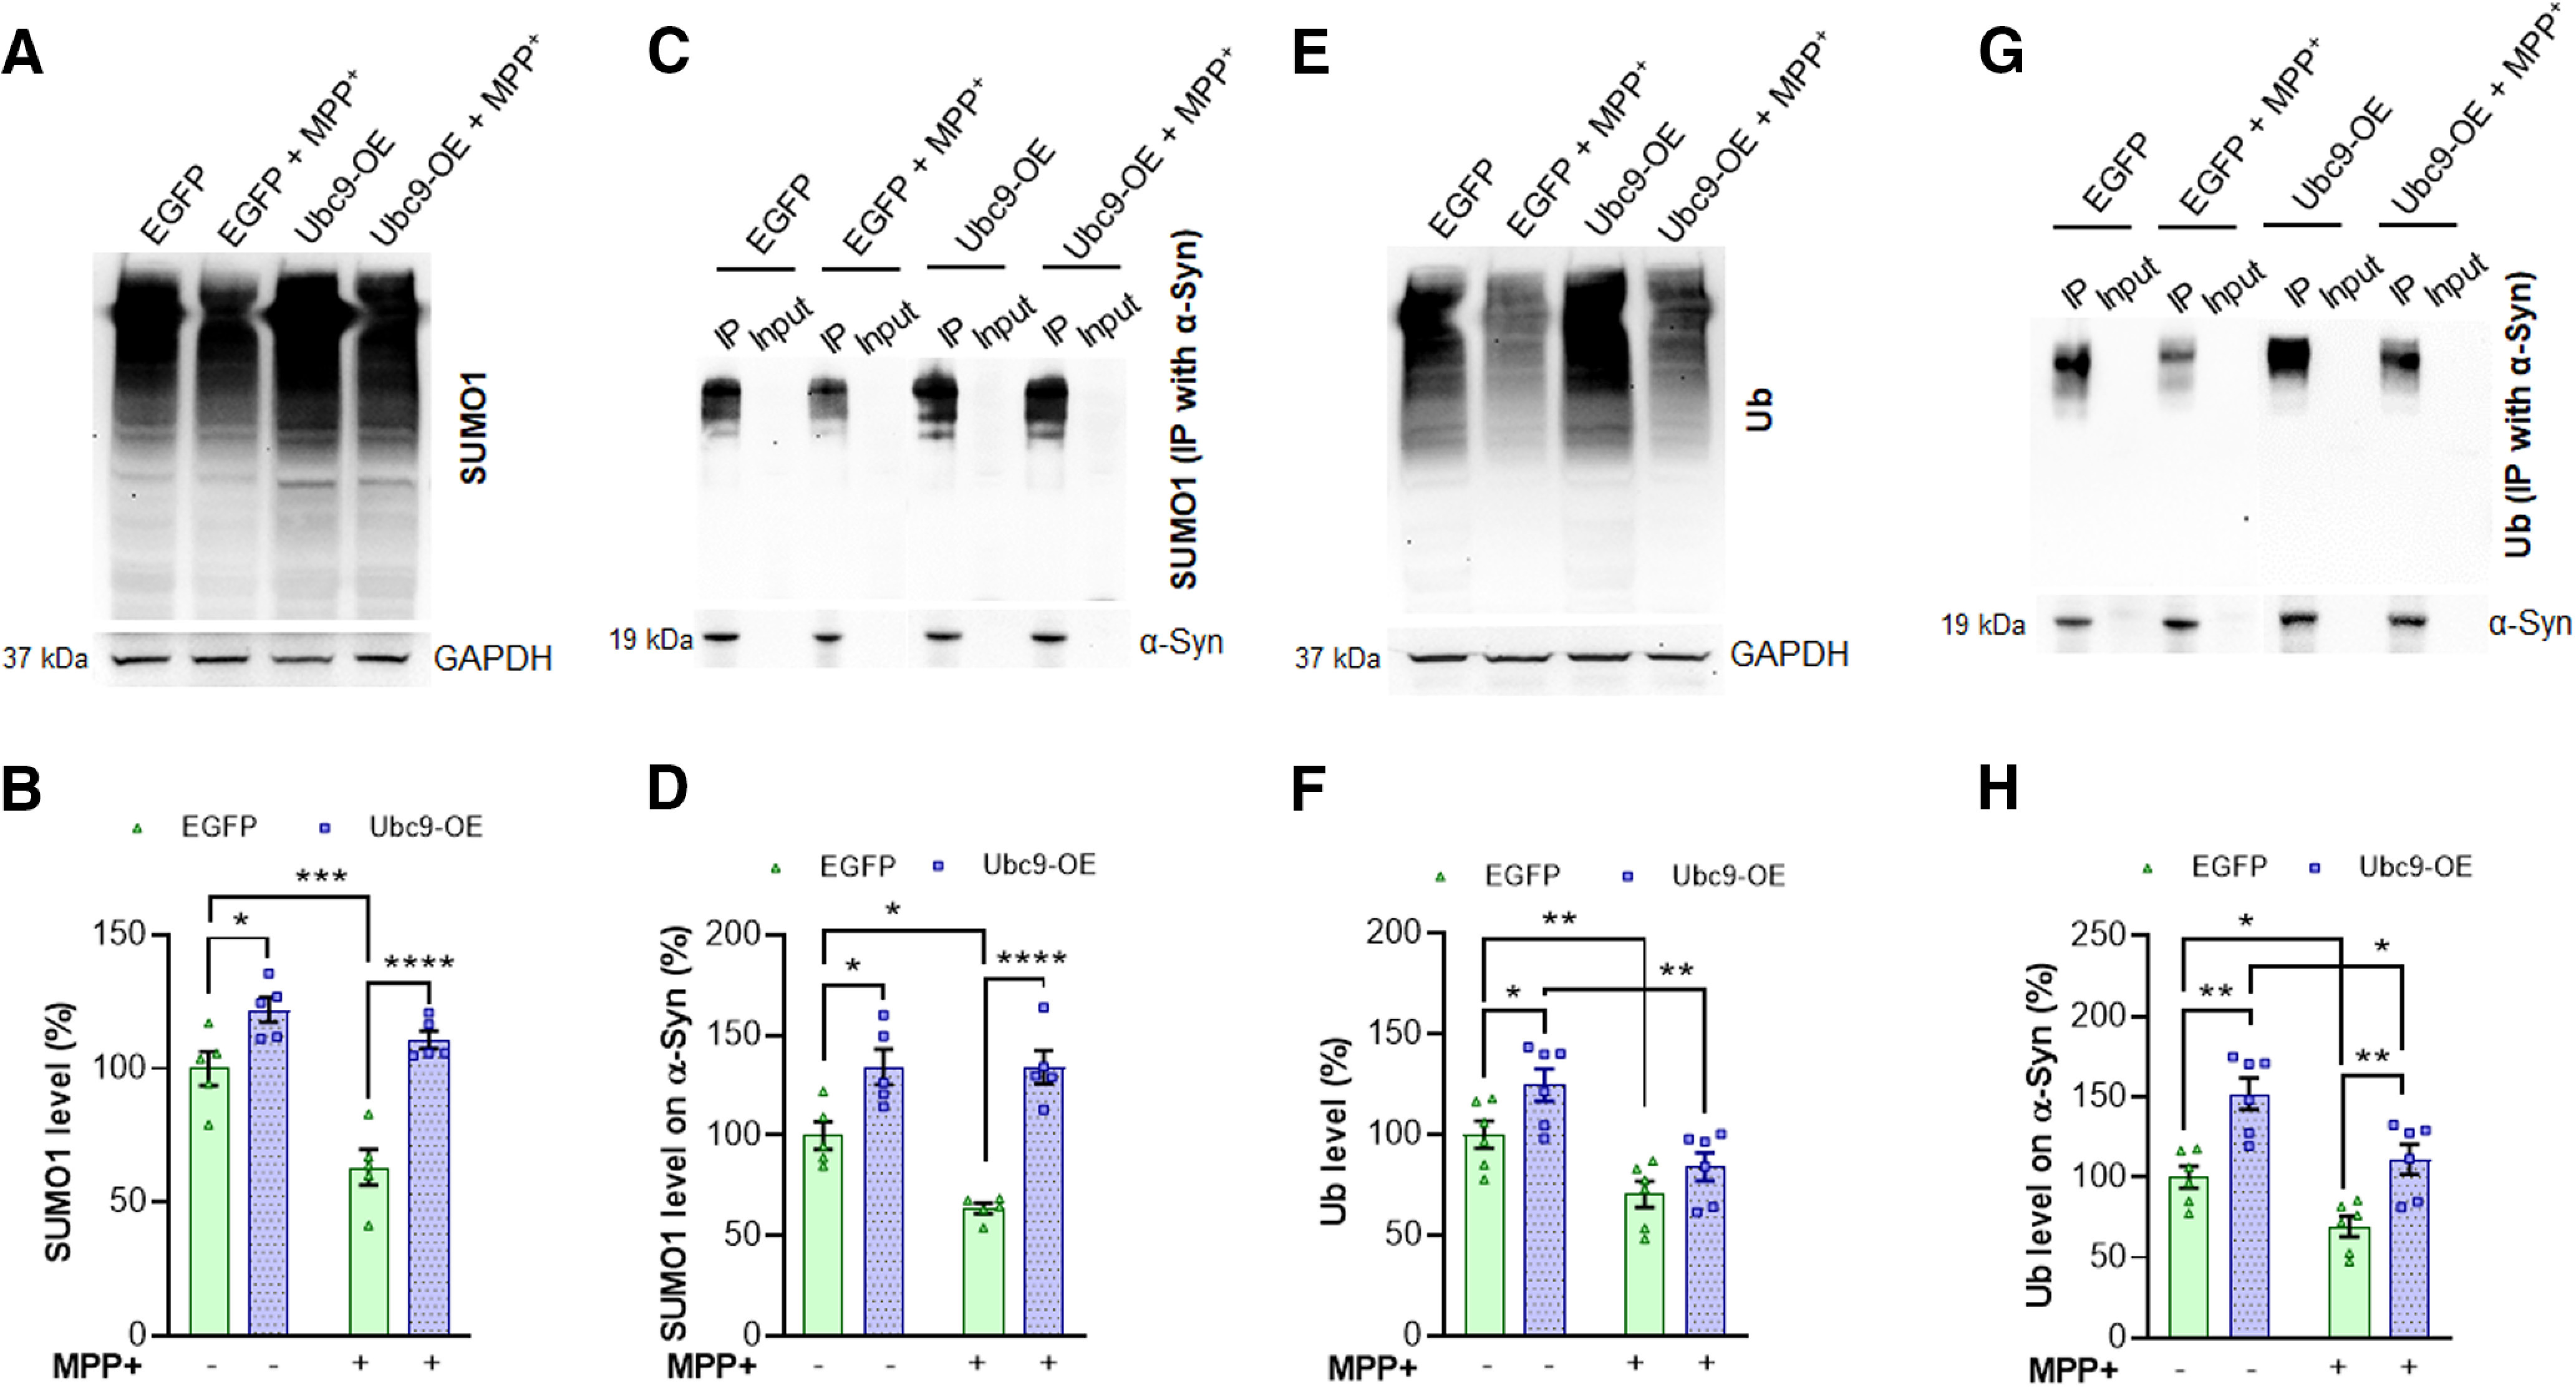
Ubc9 overexpression enhances the levels of SUMO1 and ubiquitin on α-syn, while it prevents MPP+-induced SUMO-1 removal from α-syn. A, WB images show that the level of SUMO1 was increased with Ubc9 overexpression from total cell lysates. GAPDH was used as a loading control for total cell lysates. B, MPP+ exposure significantly reduces the total amount of SUMO1 in N27-EGFP cells, while Ubc9-OE prevents MPP+-induced SUMO1 down-regulation in total cell lysates. C, In WB using IP’ed α-syn, MPP+ reduces the level of SUMO1 bound to α-syn in EGFP cells. α-Syn was used as a loading control after IPs. D, Ubc9 overexpression prevents MPP+-induced SUMO1 removal from α-syn in quantitative WB analysis. E, Examples of WB show that the total amount of ubiquitin (Ub) was reduced by MPP+ treatment. GAPDH was used as a loading control for total cell lysates. F, The levels of ubiquitin from total cell lysates were decreased by MPP+ exposure both in EGFP and Ubc9 cells. G, In WB, the levels of ubiquitin bound to α-syn were substantially reduced by MPP+ treatment. α-Syn was used as a loading control after IPs. H, MPP+ exposure results in a significant reduction of ubiquitin bound to α-syn in both EGFP and Ubc9 cells. MPP+ (640 μm) treatment for 24 h was applied to all experiments. Integrated density of WB images was measured using ImageJ. The ratios of SUMO1 or ubiquitin over respected loading control were presented as mean ± SEM in % of control. Statistical analysis was applied using two-way ANOVA, Tukey’s multiple comparison post hoc test; *p < 0.05, **p < 0.01, ***p < 0.001, ****p < 0.0001 (n = 5–8 each group).